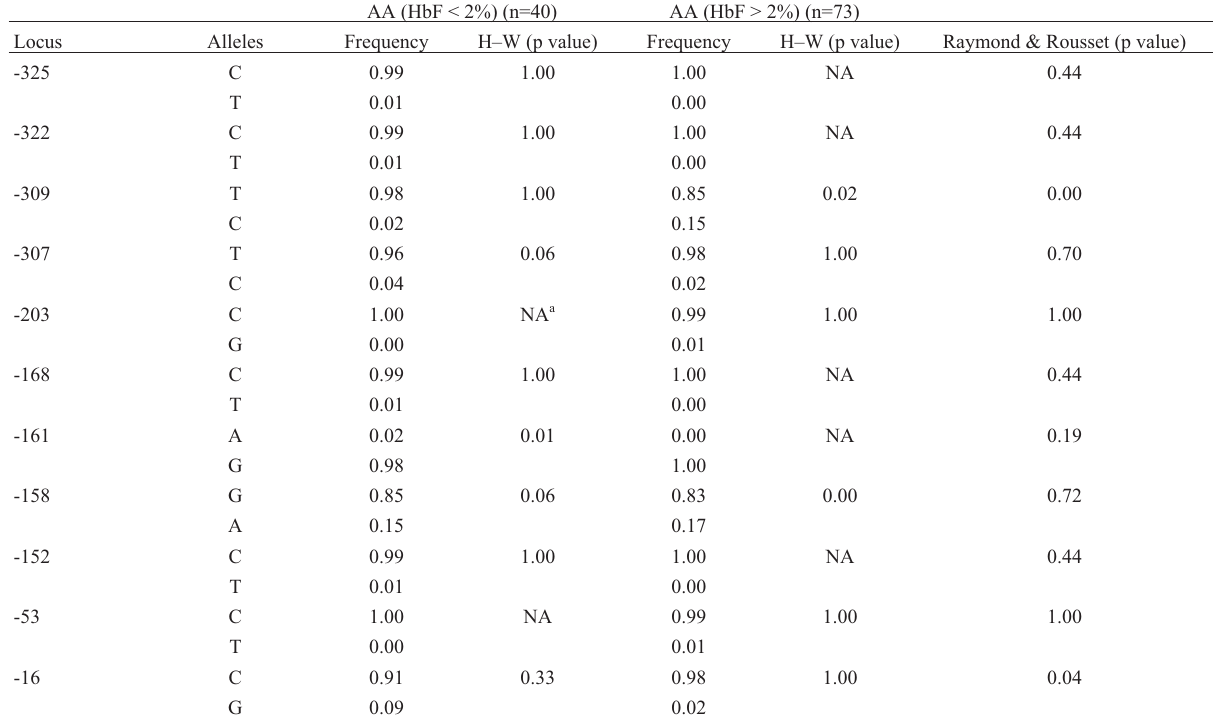
Table 2 - Allele frequency of the polymorphisms observed in the promoter region of the G-gamma globin gene in individuals without sickle cell anemia. ColumnH–W(pvalue)showsthep-valuefromtheHardy–Weinbergequilibriumtest.TheRaymond&Rousset(pvalue)columnshowsthep-valuefrom the test. 11 polymorphisms were observed. Only sites -309 and -16 presented differences in the allelic frequency between individuals with high and low